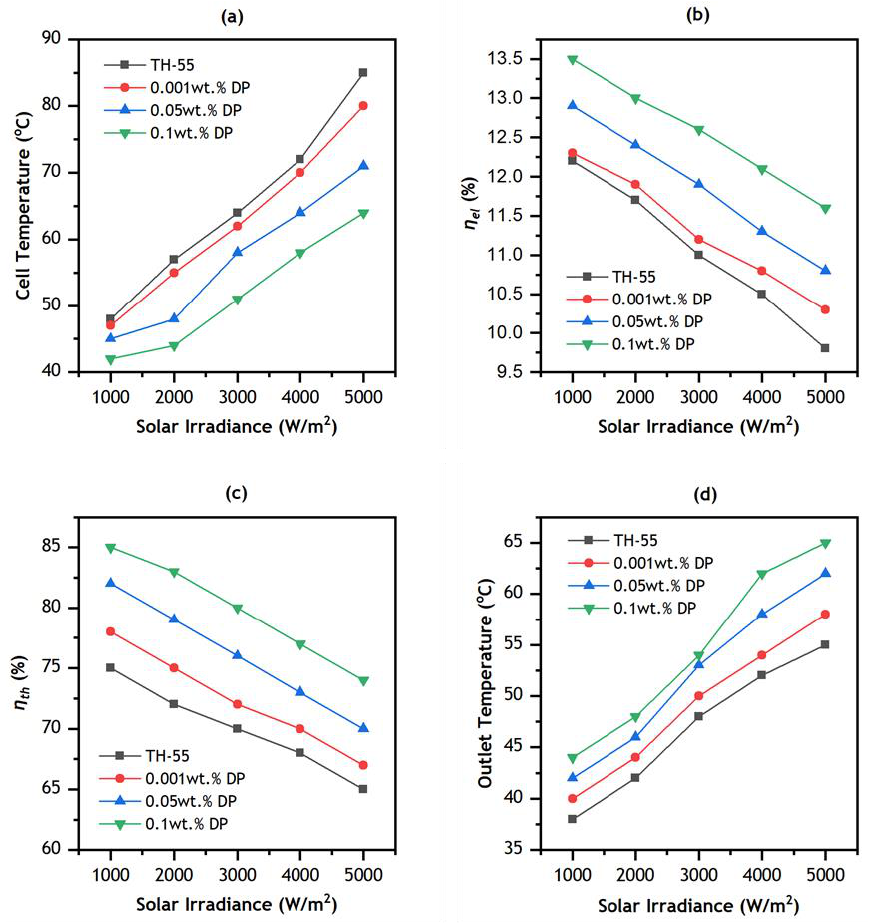
Figure 10. Variation of ( a ) cell temperature, ( b ) electrical efficiency, ( c ) thermal efficiency, and ( d ) outlet temperature, v/s irradiance at